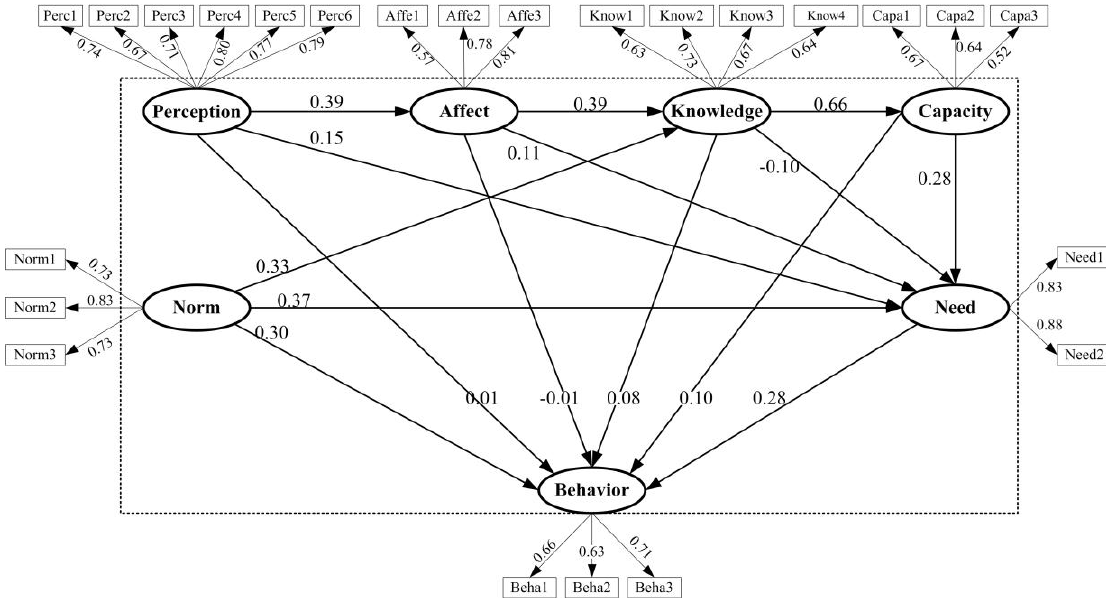
Figure 3. Results of the structural equation model. Behavior: Information seeking behavior;